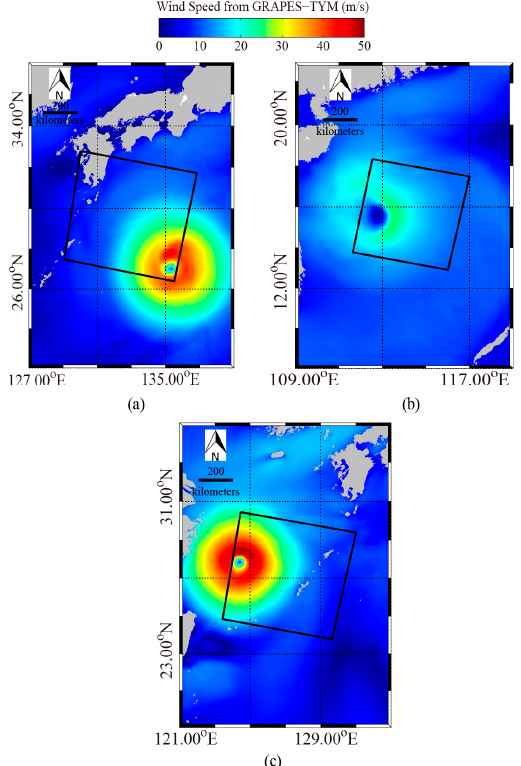
Figure 2. Global and Regional Assimilation and Prediction System—Typhoon model (GRAPES-TYM) wind maps, in which rectangles represent the coverage of the corresponding three VH-polarization GF-3 SAR images in Figure 1. ( a ) GRAPES-TYM wind maps from typhoon Noru on 2 August 2017 at 21:00 UTC. ( b ) GRAPES-TYM wind maps from typhoon Doksuri on 13 September 2017 at 22:00 UTC. ( c ) GRAPES-TYM winds maps from typhoon Talim on 14 September 2017 at 21:00 UTC.